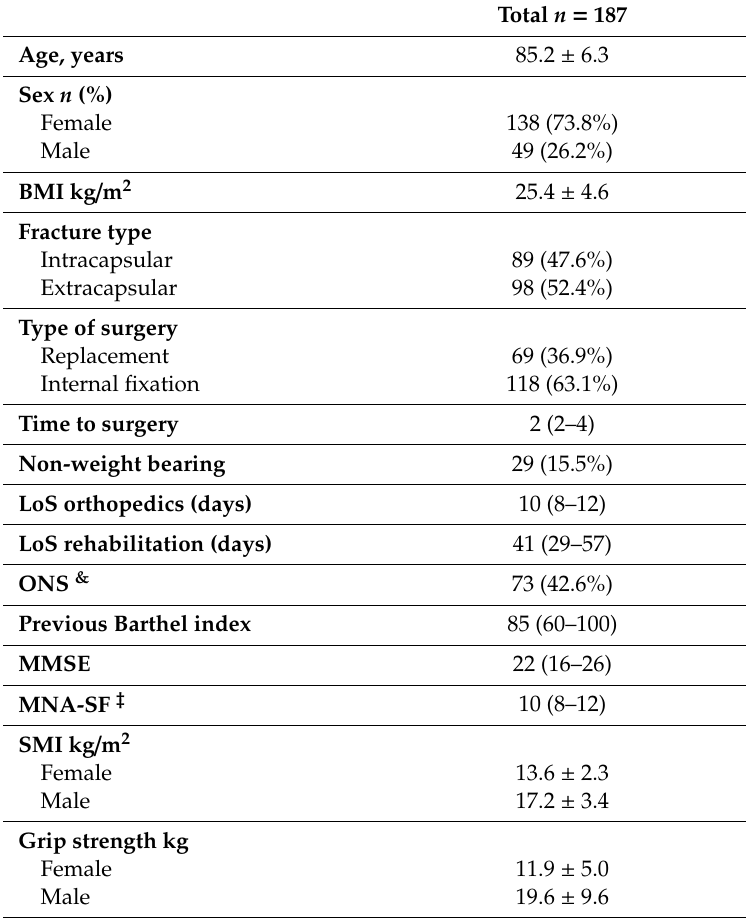
Table 1. Baseline characteristics of the study